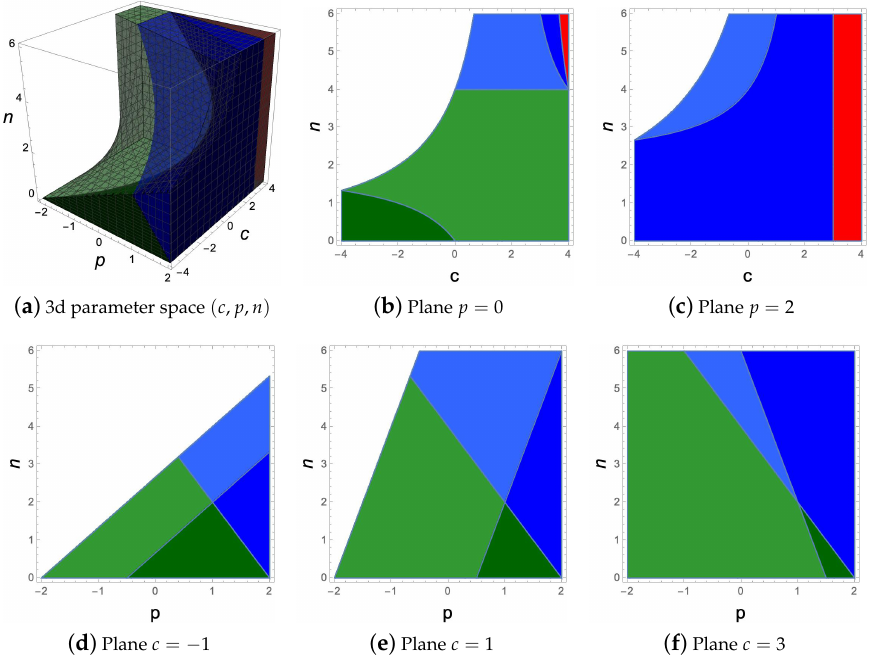
Figure 1. The parameter space of WI in the weak dissipative regime ( Q < 1) and for the monomial class of inflaton potentials. The shaded areas indicate WI has a graceful exit, while empty (white) space indicates where there is no graceful exit. The shaded areas are classified based on the behavior of Q , T / H , and T during inflation when all three increase (light green), Q decreases and both T / H and T increase (dark green), T decreases and both Q and T / H increases (light blue), T / H increases and both Q and T decreases (dark blue), and all three decrease (dark red). Figure based on